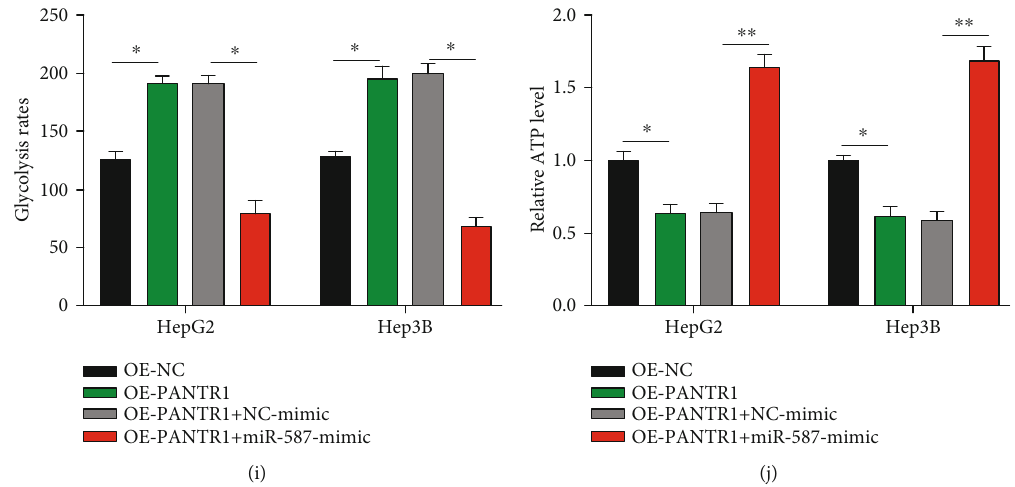
Figure 4: PANTR1 mediates HCC cell functions via sponging miR-587. (a) Transfection e ffi ciencies in HepG2 and Hep3B were analyzed by qRT-PCR. (b and c) CCK-8 assays were conducted to evaluate the cell proliferation abilities of each treated HepG2 and Hep3B cells. (d, e) Flow cytometer assay was performed to assess the cell apoptosis rate of each treated HepG2 and Hep3B cells. (f, g) Cell migration abilities were detected by performing Transwell migration assays. Comparative statistics are shown. Scale bars: 20 μ m. (h – j) The Warburg e ff ect phenomenon-related lactate production (h), glycolysis rates (i), and ATP levels (j) in treated cells were assessed. Data are shown as the mean ± standard deviation ( n = 3 ). ∗ P < 0 : 05 , ∗∗ P < 0 : 01 , and ∗∗∗ P < 0 : 001 (Figure 2(a)) ( ∗∗ P < 0 : 01 ). CCK-8 assay results suggest that downregulated PANTR1 inhibited cell proliferation